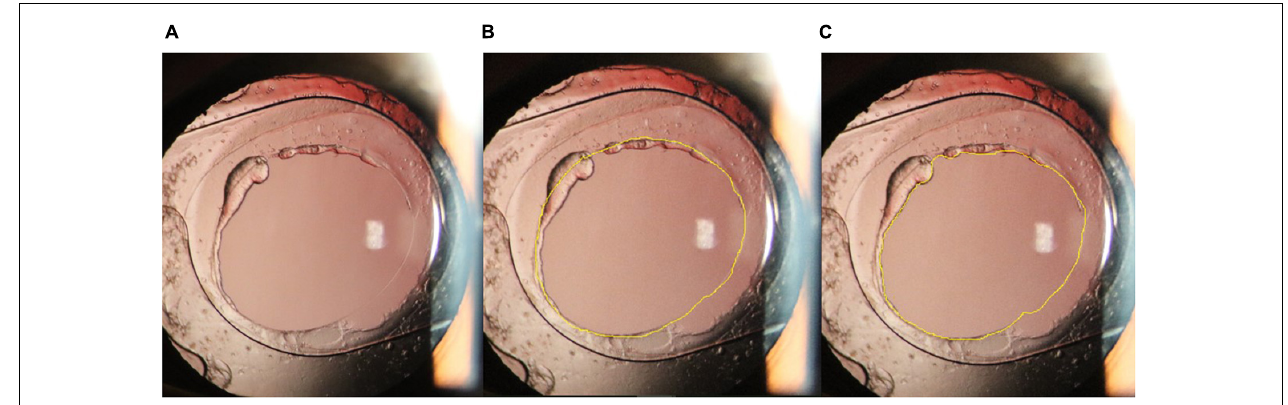
FIGURE 1 | (A) : Anterior segment photography of the eye with an intraocular lens one year after surgery. (B): Contour of the posterior capsular opening area (yellow line). (C) : Contour of the visual axis transparent area (yellow line).